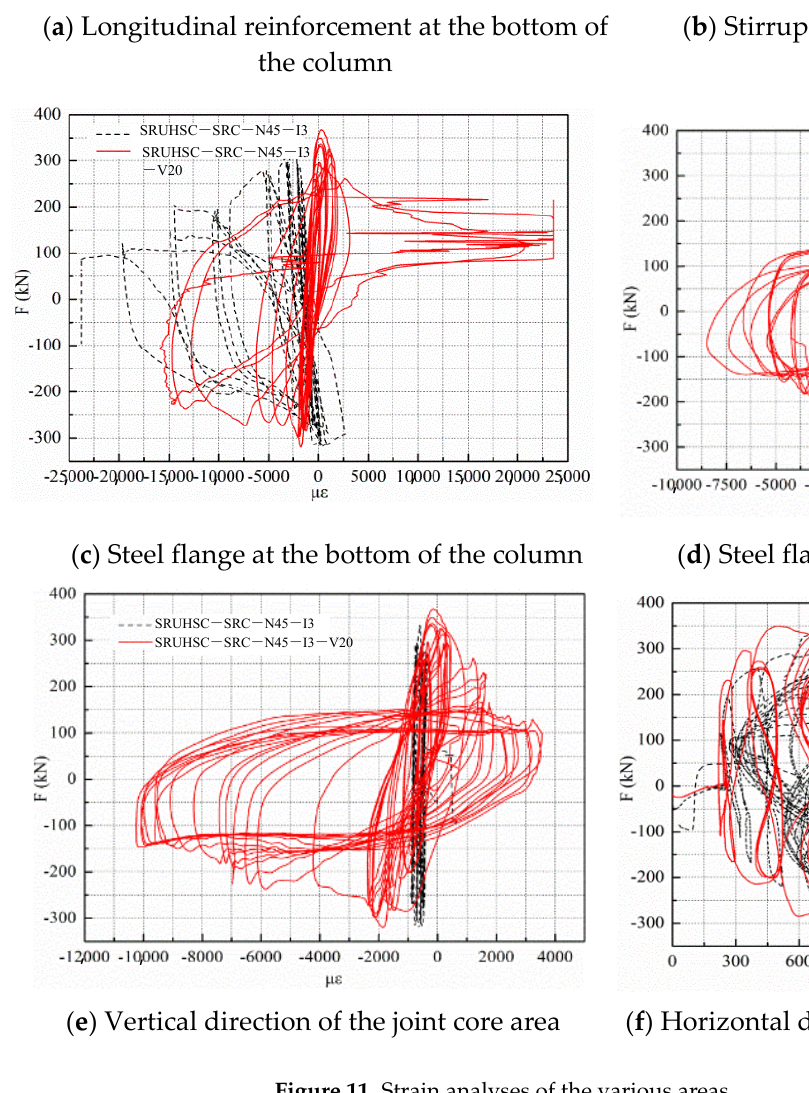
Figure 11. Strain analyses of the various areas. ( a ) Longitudinal reinforcement at the bottom of the column; ( b ) Stirrup at the bottom of the column; ( c ) Steel flange at the bottom of the column; ( d ) Steel flange at the end of the beam; ( e ) Vertical direction of the joint core area; ( f ) Horizontal direction of the joint core region